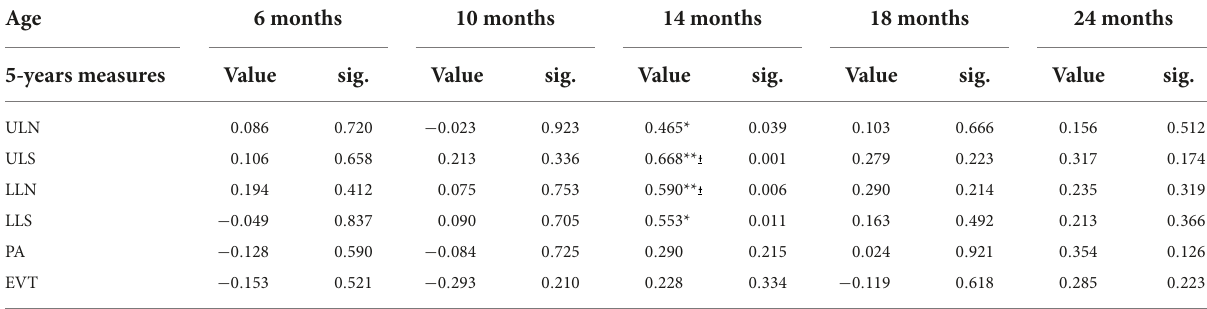
TABLE 6 Correlations between PT (parentese) at 6–24-months and reading-related measures at 5-years of age for the smaller sample of 20 participants with brain imaging data at 26-months.